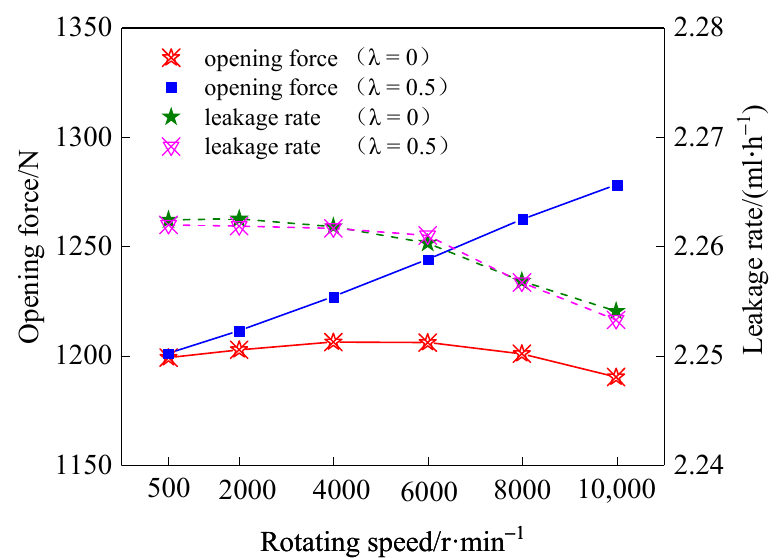
Figure 6. Characteristic performance curve of the diffuser self-pumping mechanical seal. ( r k = 34 mm, h ki = h g = 50 μ m, r o = 30.6 mm, N g = 32, γ = 0.5, α = 30°, Δ p = 0.5 MPa).